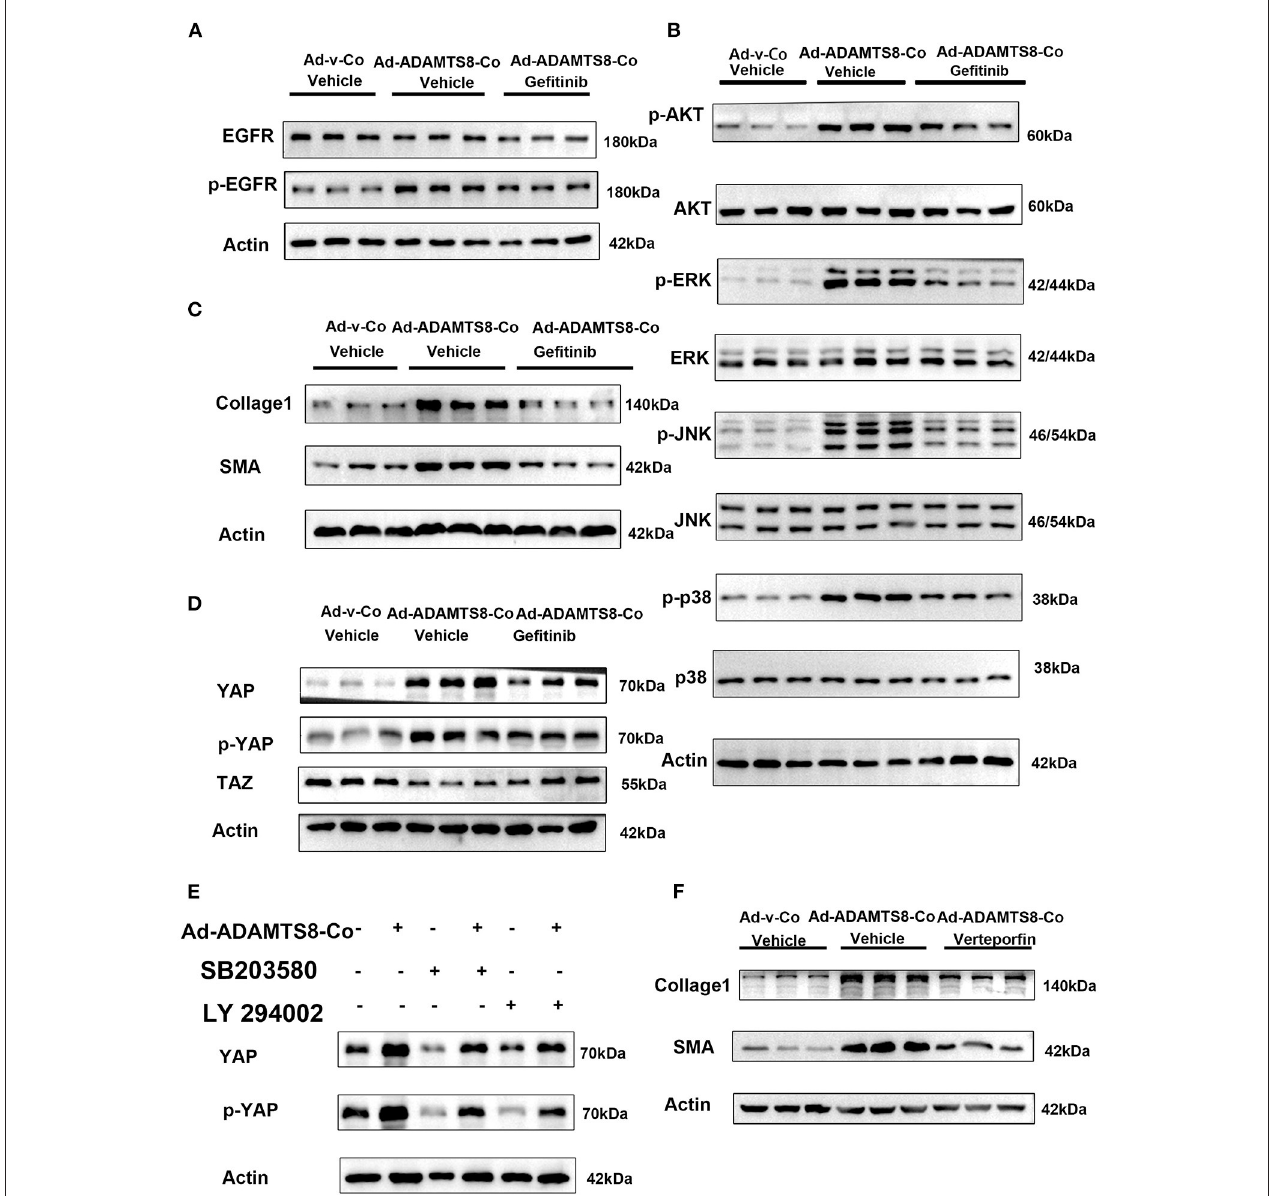
FIGURE 7 | ADAMTS8 activated YAP, and inhibiting the EGFR expression blocked the ADAMTS8-induced YAP activation in cultured cardiac fibroblasts. (A,B) The phosphorylation levels of EGFR and its downstream MAPK and AKT were all attenuated in the gefitinib group. (C) EGFR inhibitor abated ADAMTS8-induced cardiac fibroblast activation. (D) Cardiac fibroblasts co-cultured with cardiomyocytes transfected with ADAMTS8 overexpressing adenovirus (Ad-ADAMTS8-Co) were treated with or without gefitinib, followed by analysis of the cell lysates with indicated antibodies. (E) The protein levels of collagen1 and α -SMA were all partly declined in the verteporfin group. (F) Cardiac fibroblasts co-cultured with cardiomyocytes infected with ADAMTS8 overexpressing adenovirus were treated with the MAPK pathway inhibitor SB203580 or AKT inhibitor LY294002 after quiescence, followed by analysis of the cell lysates with indicated antibodies.